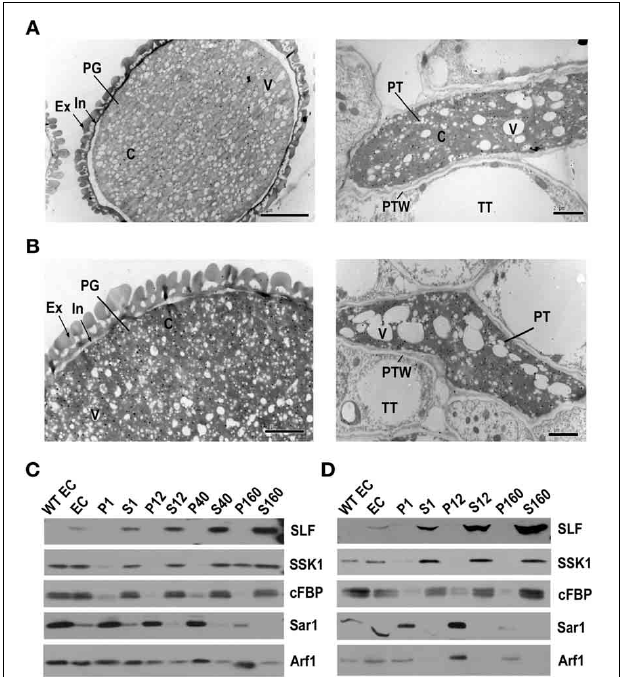
FIGURE 1 | PhS 3L -SLF1 and PhSSK1 are both located in the cytosol of pollen grains and pollen tubes. (A) Immunogold labeling of PhS 3L -SLF1::FLAG in pollen grain (left) and pollen tube (right). (B) Immunogold labeling of PhSSK1 in pollen grain (left) and pollen tube (right). PG, pollen grain; Ex, exine; In, intine (arrow); C, cytosol; V, vacuole; PT, pollen tube; PTW, pollen tube wall; TT, transmitting tract tissue. (C) Western blot detection of PhS 3L -SLF1::FLAG (SLF) and PhSSK1 (SSK1) in subcellular fractions of pollen grains. (D) Western blot detection of PhS 3L -SLF1::FLAG (SLF) and PhSSK1 (SSK1) in subcellular fractions of in vitro germinated pollen tubes. WT EC and EC denote entire cell homogenates from wild-type and the transgenic pollen grains or pollen tubes, respectively. Pellet fractions (P1, P12, P40, and P160) and supernatant fractions (S1, S12, S40, and S160) are derived from differential centrifugation at 1000, 12,000, 40,000, and 160,000g, respectively. cFBP, Sar1, and Arf1 are marker antibodies for cytosol, endoplasmic reticulum (ER) and Golgi,